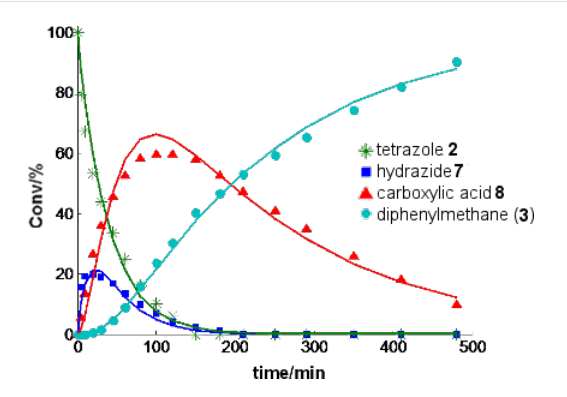
Figure 4: Decomposition of tetrazole 2 in a 4 mL resistance heated stainless steel coil at a nominal temperature of 220 °C in a NMP/ AcOH/H 2 O 5:3:2 mixture (0.125 M) (points: experimental results; solid lines: predicted with a rate law according Scheme 3 on the assump- tion that the rate constants are proportional to the residence time k i = a i · t (i.e., inversely proportional to the flow rate k i = a i · V ∙ v − 1 , t = resi- dence time, V = reactor volume, v = flow rate) with a 1 = 0.169 × 10 − 3 , a 2 = 0.166 × 10 − 3 and a 3 = 0.0207 × 10 − 3 s − 2 ). Conversions in percent were derived from HPLC-UV (215 nm) peak area integration without correction for response factors. Similar curves for different coils are shown in Figure S5 in the Supporting Information File